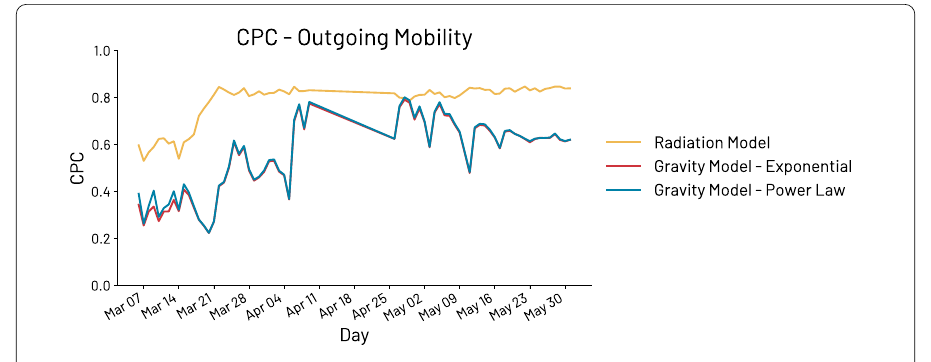
Figure 4 CPC of the three models on the outgoing mobility. Radiation model (yellow), gravity with exponential decay (red) and gravity with power law decay (blue) have similar performances in the first period while the best model during the introduction of non-pharmaceutical interventions is the radiation model (average CPC 0.815)